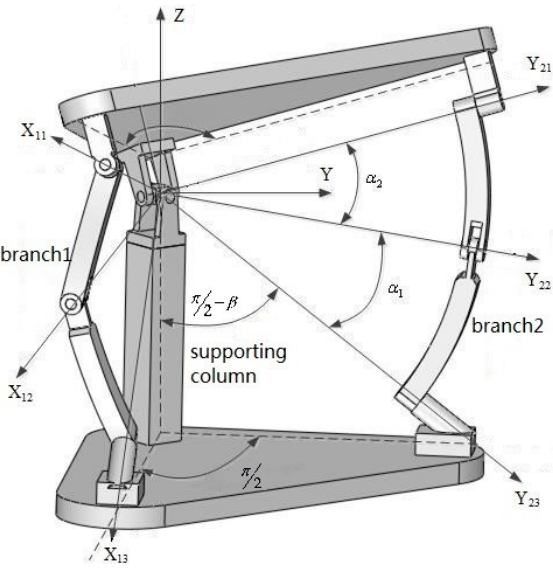
Figure 1. Structure of the 2-degrees of freedom (DOF) spherical parallel mechanism (SPM).